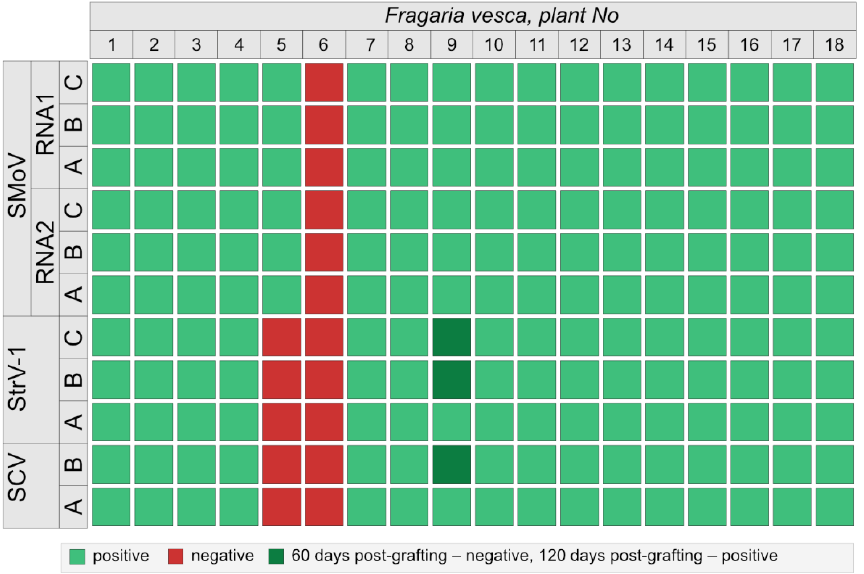
Figure 1. Virus testing for SCV, SMoV and StrV-1 and their variants following grafting of the CRM3 plant to 16 F. vesca recipient plants after 30 dpg; plants 5, 6 and 9 were additionally tested 60 dpg.